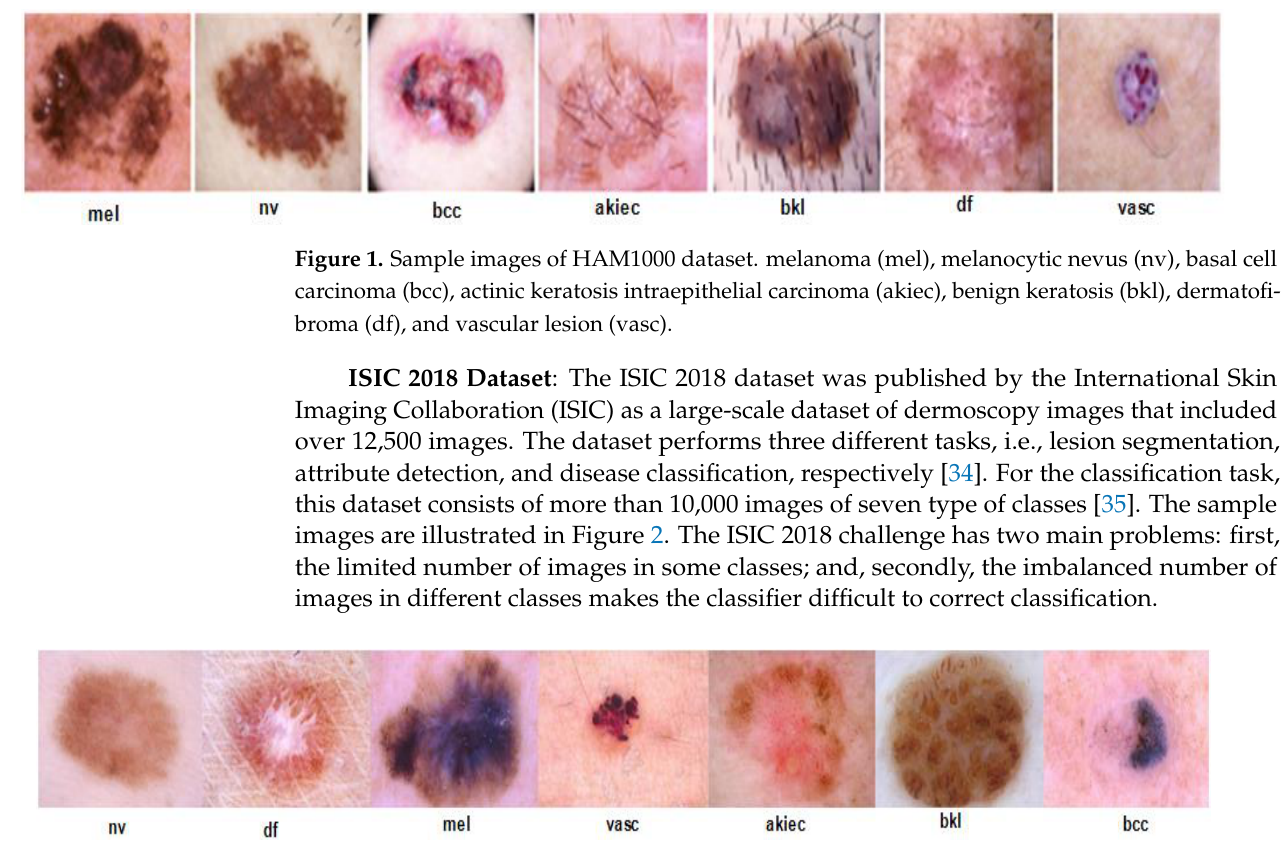
Figure 2. Sample images of ISIC 2018 dataset.